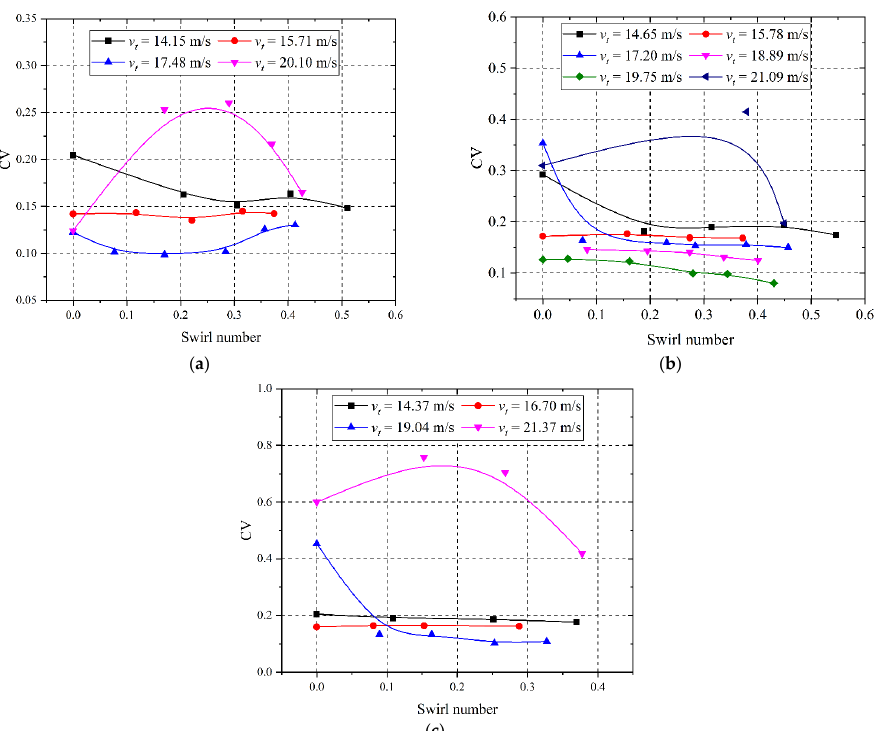
Figure 16. Effect of swirl number on coefficient of variation of pebble particles. ( a ) d p = 3 – 5 mm, ( b ) d p = 5 – 7 mm, ( c ) d p = 7 – 9 mm. Comparing the pure axial flow field with the swirl flow field, the accuracy of particle pickup velocities obtained by visual observation is the worst, and it reaches the best when the particle mass loss rate of selecting is selected as the index. For particle conveying which is not convenient to measure the particle pickup ratio, the particle pickup velocity, and the optimal swirl number could be obtained qualitatively by measuring the airflow pressure drop, the CV of pressure signals, and the PAR.